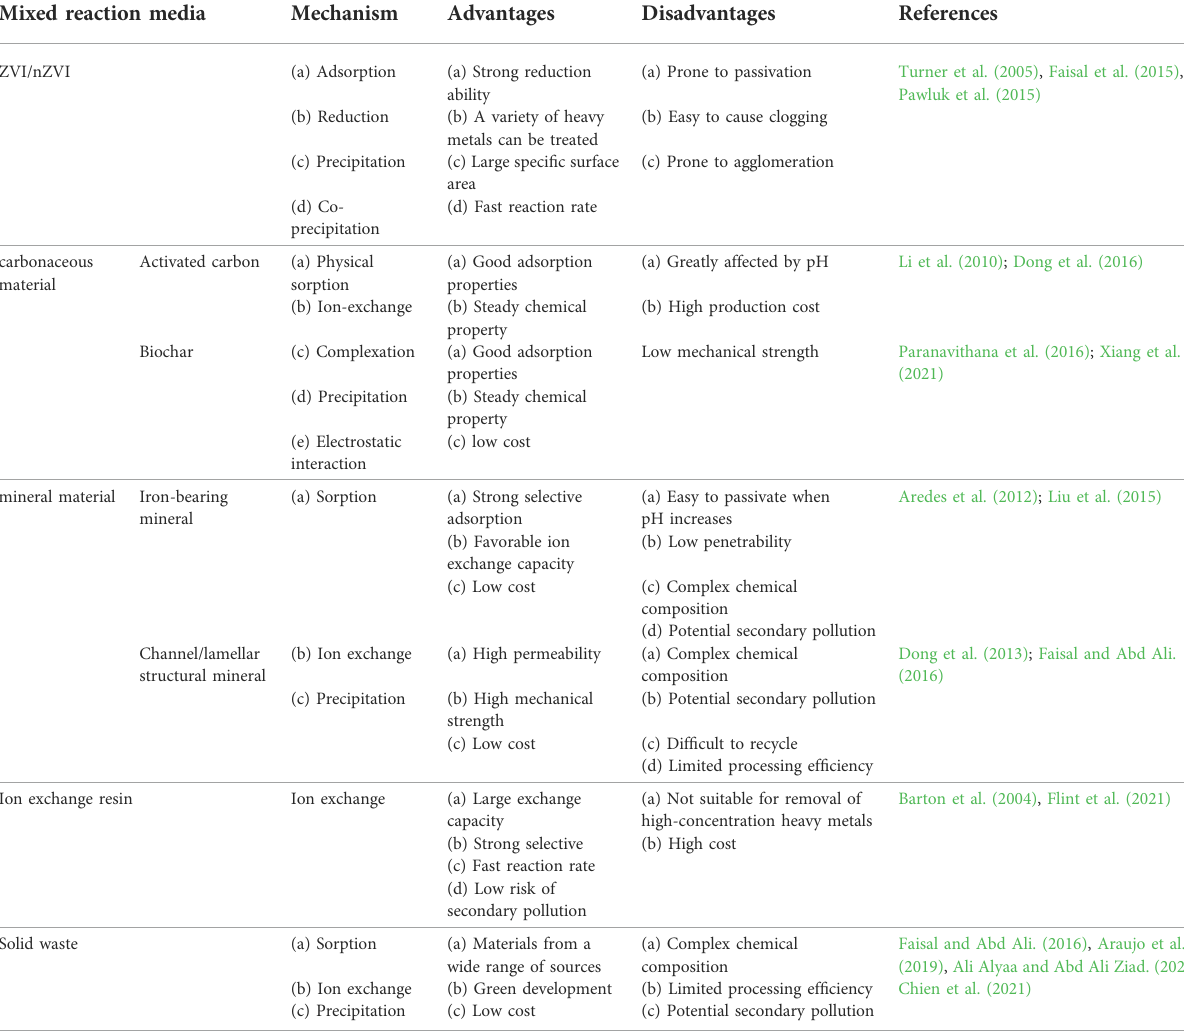
TABLE 1 Analysis of the advantages and disadvantages of single reaction medium to remove heavy